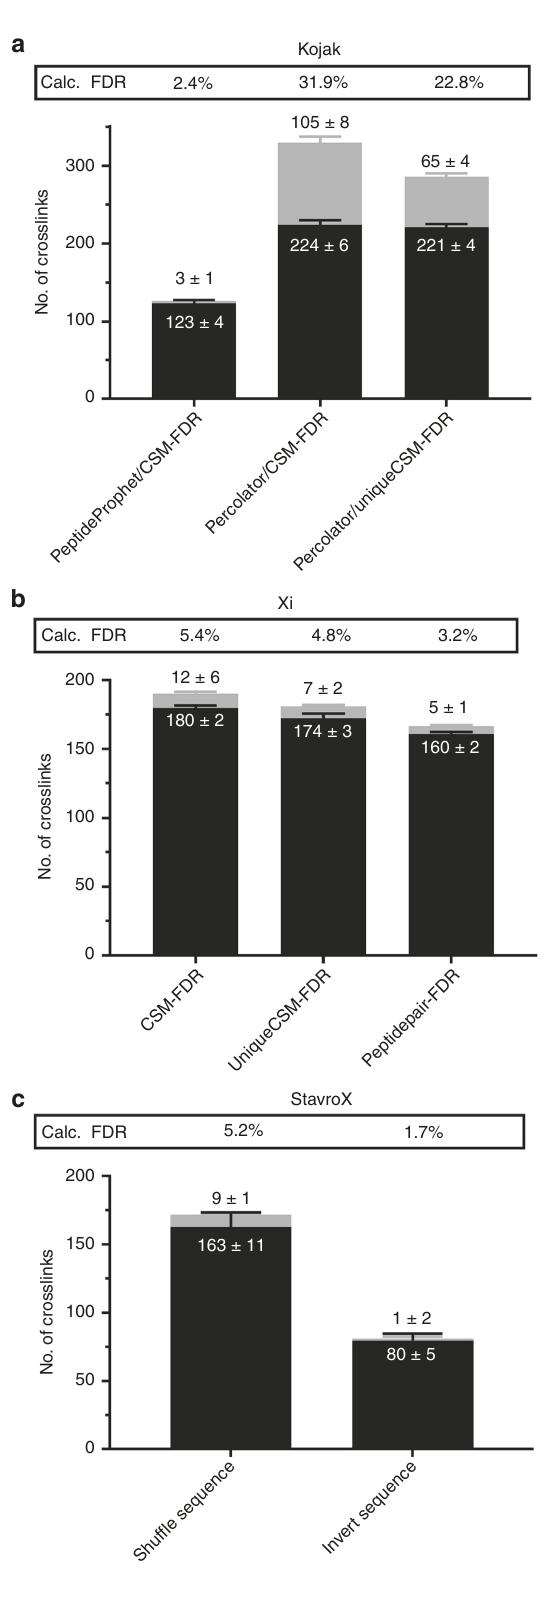
Fig. 3 Effect of crosslink validation strategies on overall results. a Kojak results were validated by PeptideProphet or Percolator with which all CSMs were used, or only the top-scoring CSM for each species. b Xi results were validated at the CSM-FDR level, the unique CSM-FDR level or at the peptide pair-FDR level. c StavroX results were validated against a decoy database in which the sequences were shuf fl ed with the protease sites remaining unchanged, or in which the sequences were inverted. All values are provided in Supplementary Table 6, and the average values± standard deviation are shown on the stacked box plots. All results fi les can be found in Supplementary Data 1. Error bars correspond to the standard deviation between technical replicates ( n